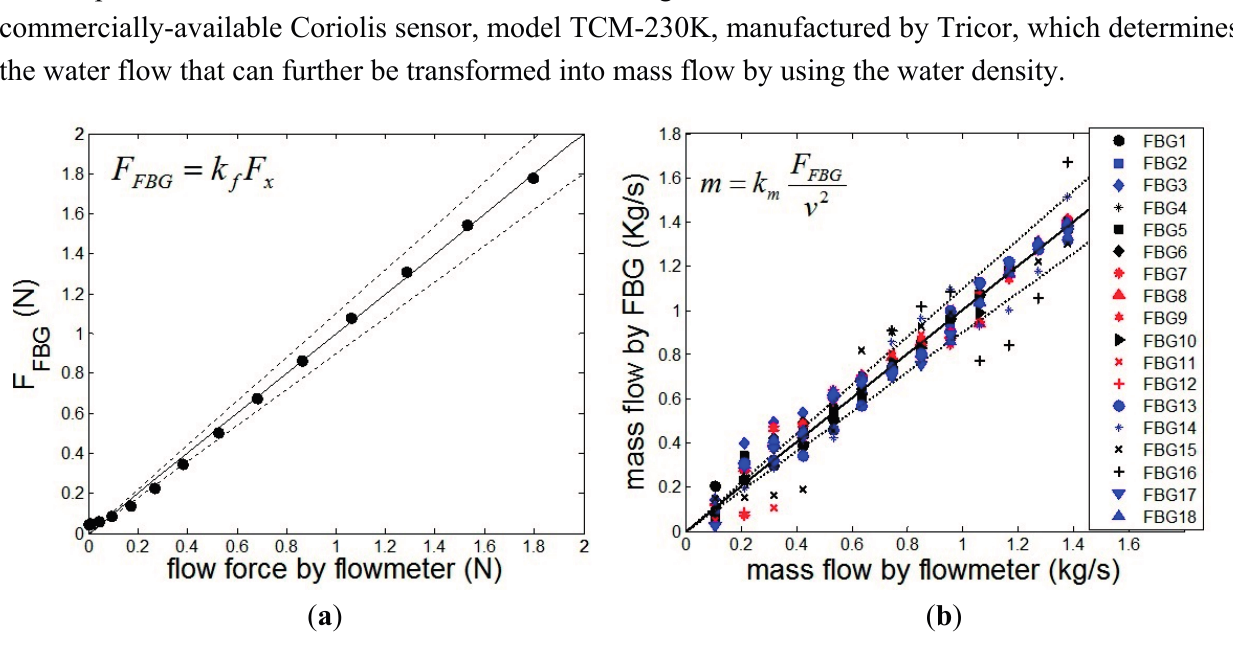
Figure 4. ( a ) Measurement of the flow-induced force to the optical fiber Bragg grating against the flow force determined by the flow properties; ( b ) Measurement of the mass flow for all 18 sensors, indicating the good agreement between the FBG and standard mass flow meter. In both plots, the solid line is at 45°, indicating the position where all values should converge, and the dashed lines indicate a ±10%